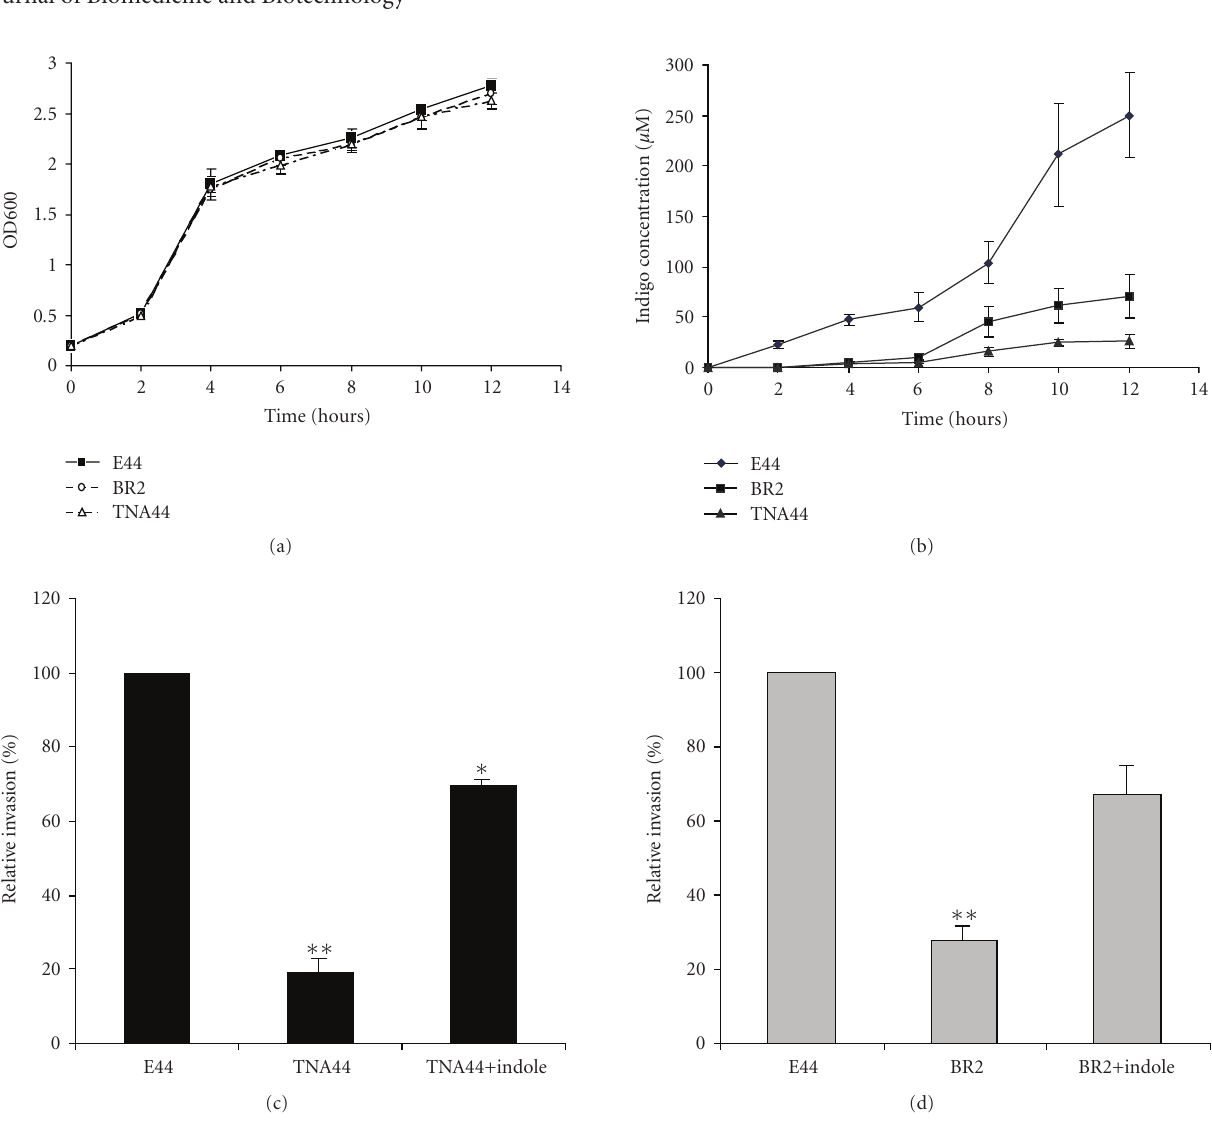
of TNA44 (Figure 4(c)) and BR2 (Figure 4(d)). Lacour and Landini have shown that the rpoS gene in E. coli K12